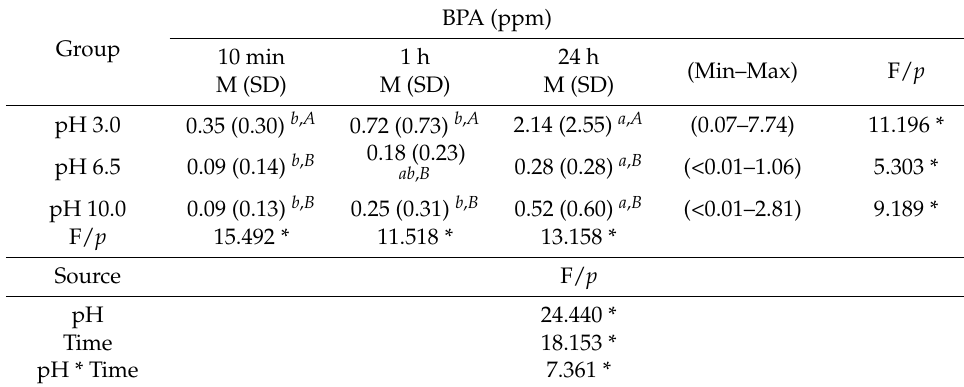
Table 5. The difference in BPA concentration (ppm) according to pH levels and time.